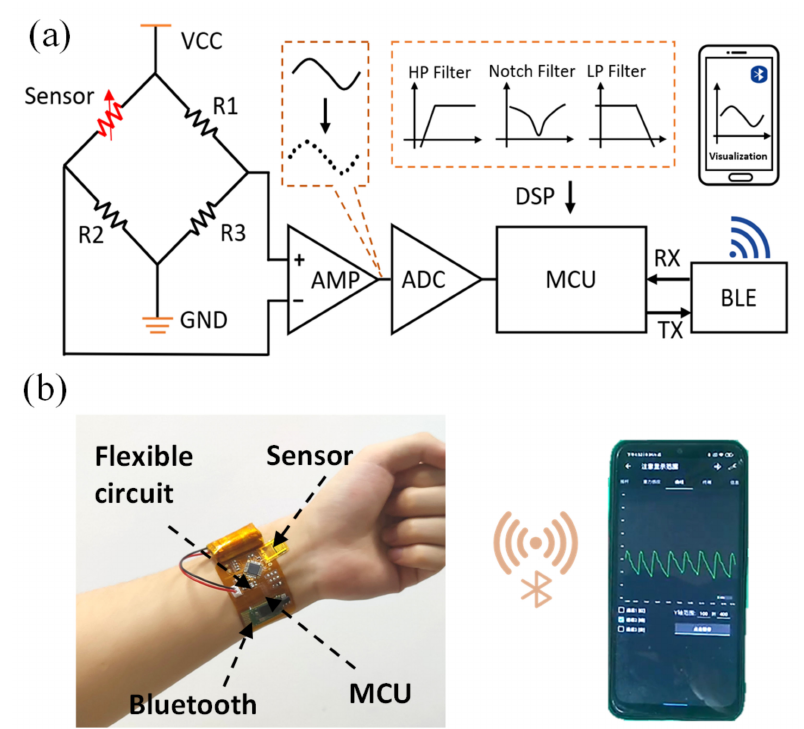
Figure 6. ( a ) Functional block diagram of pulse pressure signal acquisition; ( b ) The FPS is attached to the skin together with the flexible processing circuit. By connecting to the Bluetooth of mobile phone, the remote monitoring of RAPP was